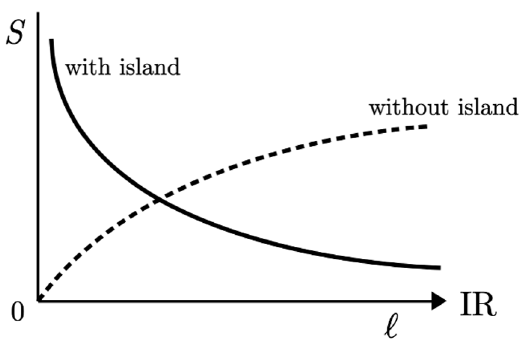
Figure 4. The entropy as a function of the world-sheet length scale ‘ . When there are no islands, the entropy is increasing towards the IR, whereas it goes to zero when an island is